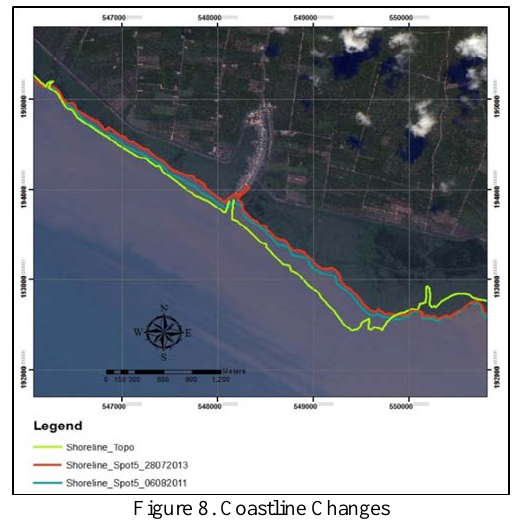
Figure 8. Coastline